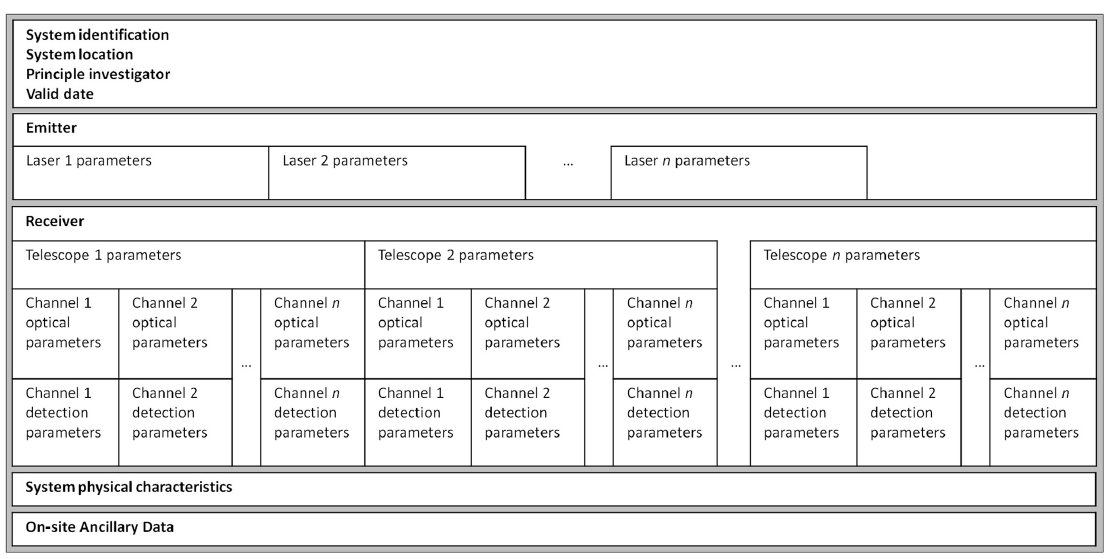
Figure 4. Schematic representation of an instrument table from the EARLINET Handbook of Instruments. The structure allows for multiple emitting lasers (with multiple beams) and a multi-telescope receiving system. As a result, each detection channel is fully characterized. Also, any change or expansion of the lidar system can be uniquely